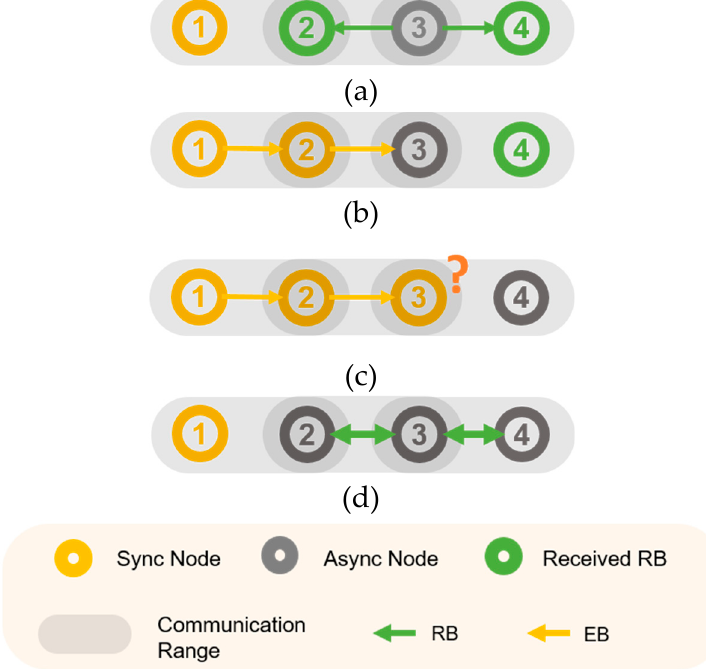
Figure 4. Two-way Rendezvous Benefits ( a ) Node 3 sends rendezvous packets, so nodes 2 and 4 receive ( b ) Node 2 is synchronized and sends EB to node 3’s channel ( c ) Node 3 does not know channel 4’s channel information ( d ) 2-way transmission rendezvous packet transmission strategy.